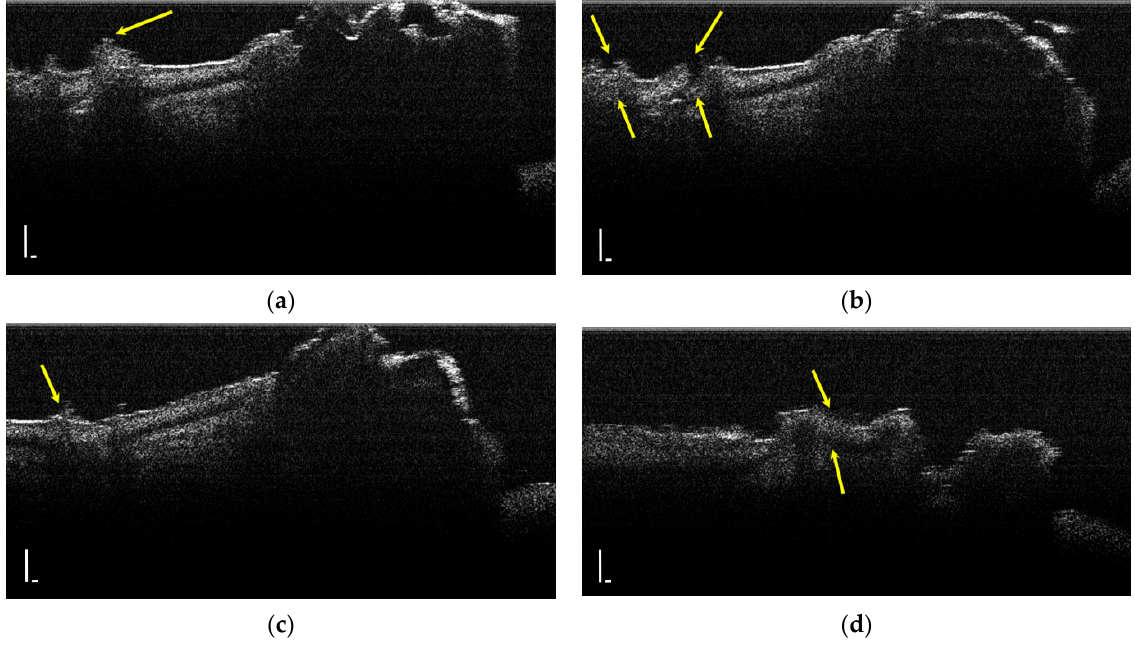
Figure 3. Hypoplasia lesion (surrounded by the red oval) on the palatal surface of 27.